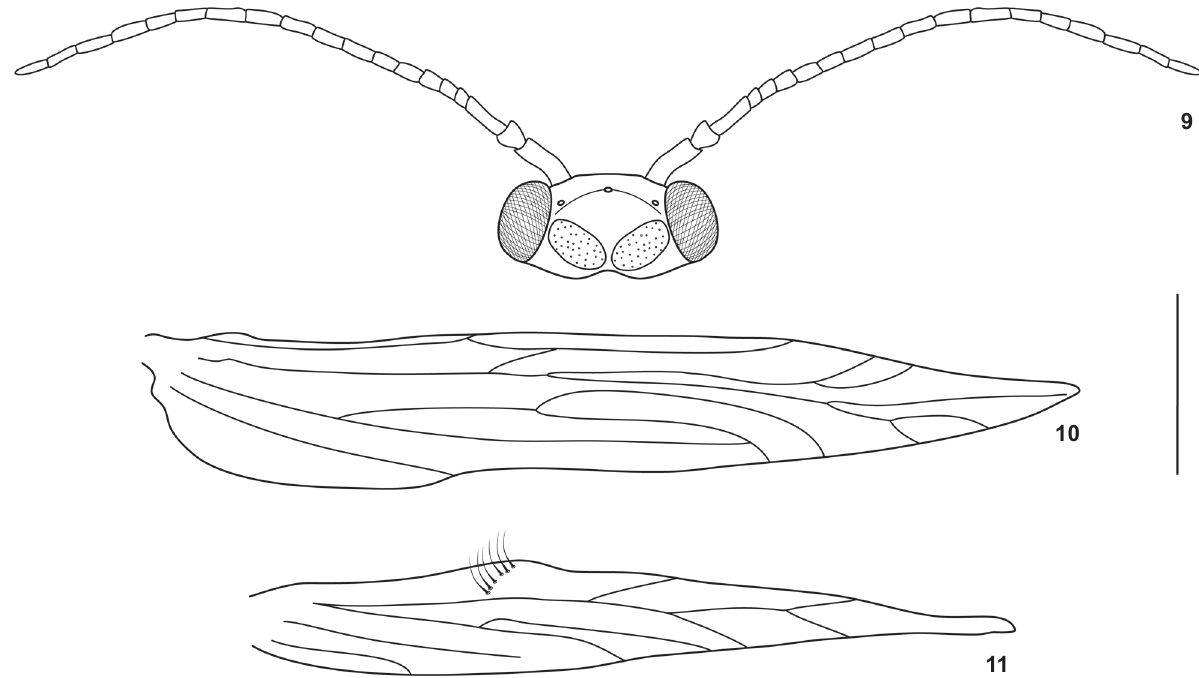
(Fig. 13), and phallus without basal loop and with apical spatu- late process in dorsal view (Fig.